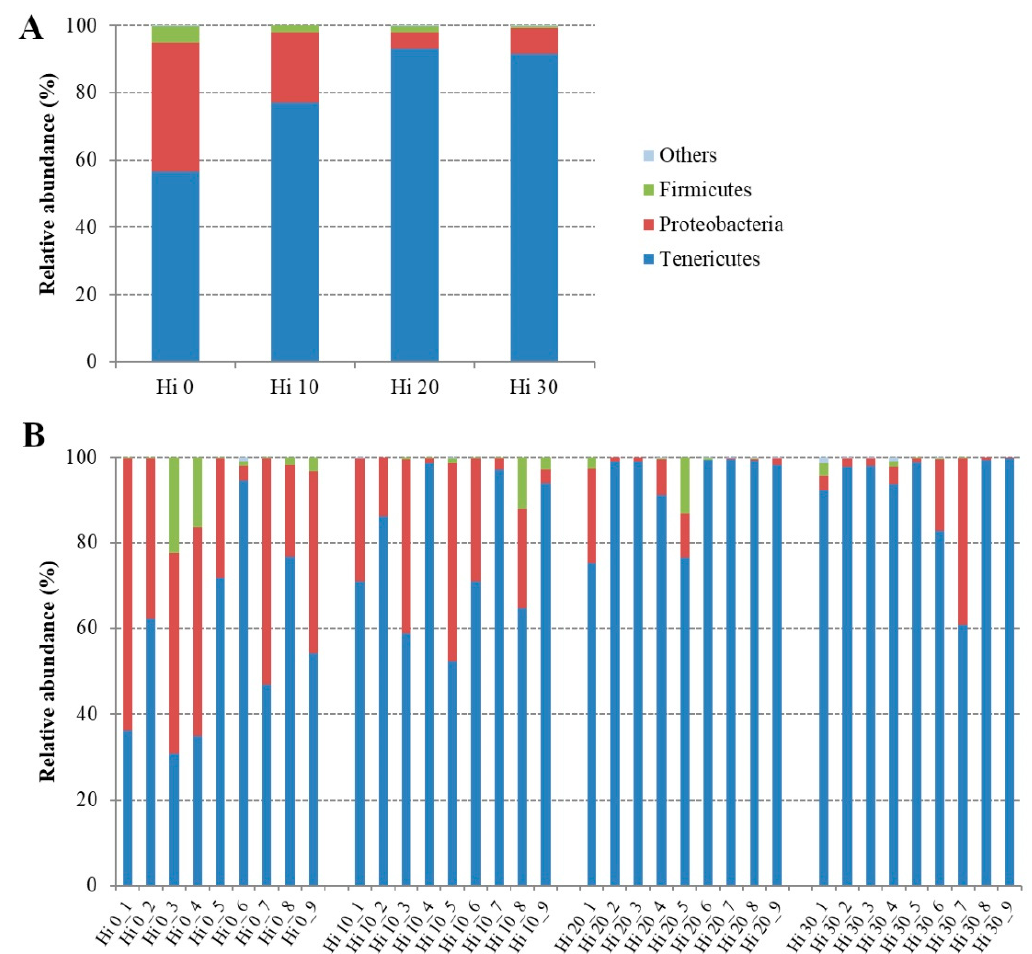
Figure 2. Relative abundance (%) of the overall most prevalent bacterial phyla in each dietary groups ( A ) and individual fish ( B ). In the figure, all taxa with an overall abundance of ≥ 1% were reported.